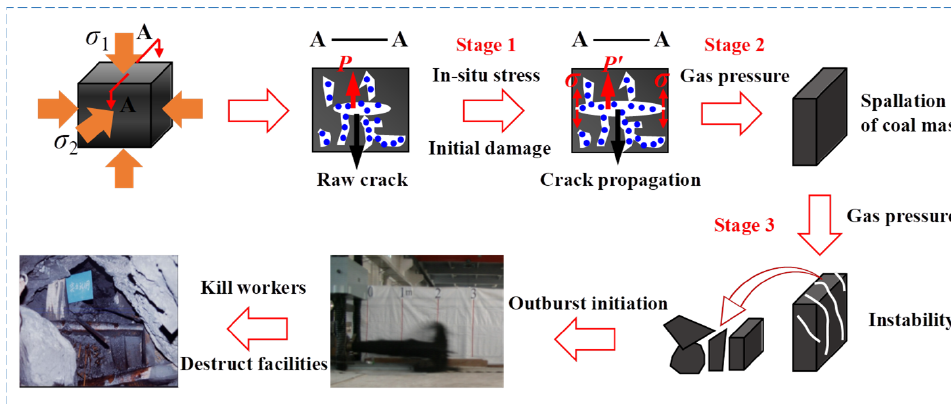
Figure 10. The mechanical process of an outburst initiation.